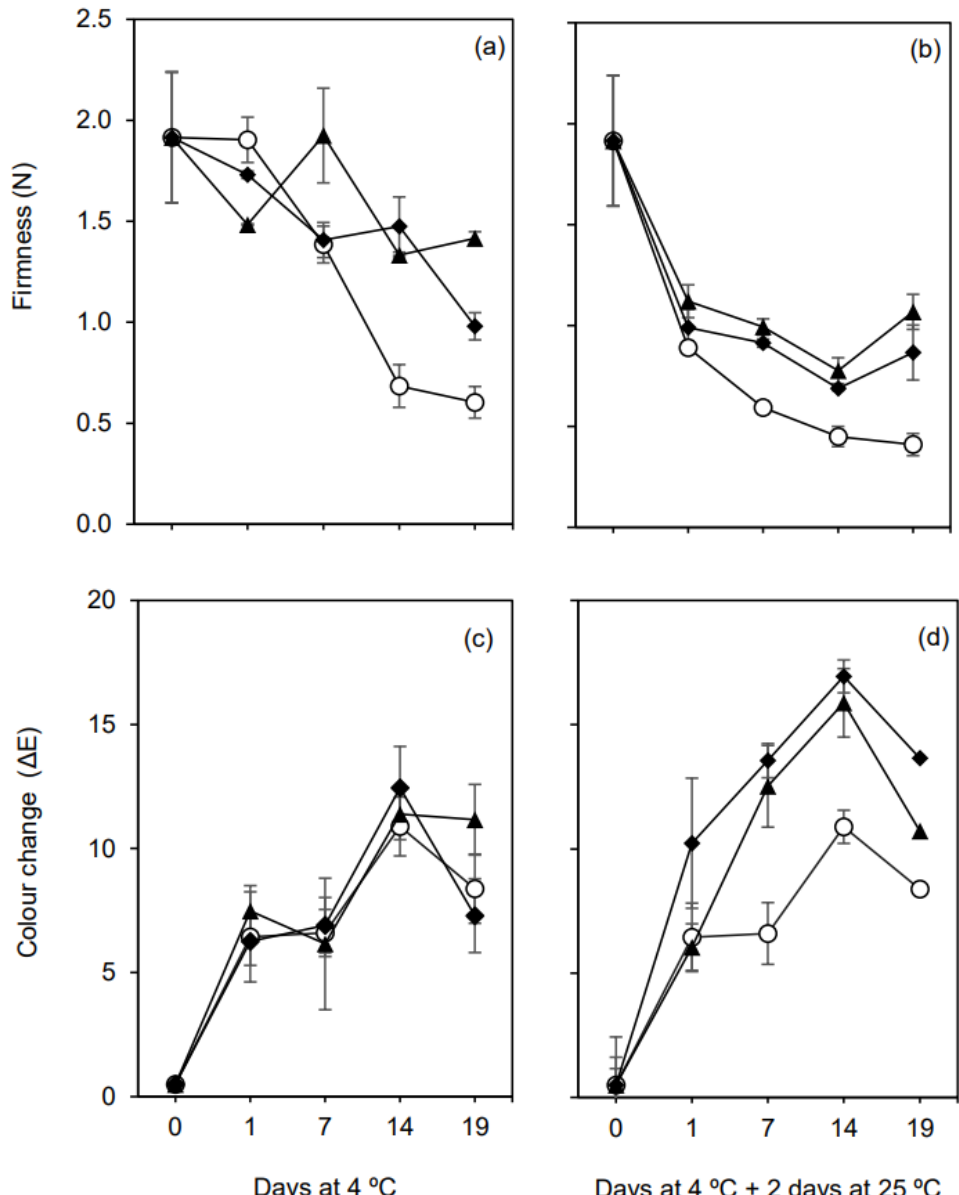
Figure 5. Firmness (N) and colour changes on the skin of the fruits ( Δ E) for figs ( Ficus carica L. var. ´ Pingo de mel ´ ) coated ( (cid:117) C-OO-TPP and (cid:115) A-OO-Ca) and uncoated ( Ctr), under refrigeration (cid:35) for over 19 days at 4 °C ( a , c ) and after being transferred to room temperature for 2 days ( b , d ). Each symbol represents each experimental condition, which is associated to a line. Color is one of the most important attributes of fruit quality. Figure 5c,d show the surface color changes of coated and uncoated fig fruits during storage at refrigerated conditions (4 ◦ C), and after leaving the refrigerated chamber and maintained at room temperature (25 ◦ C) for 2 days. All samples showed a high ∆ E value (>6) at 1 day of cold storage, increasing progressively until the end of that storage period, up to around 7.3 to 11.2, with non-significant differences between coated and uncoated fruits (Figure